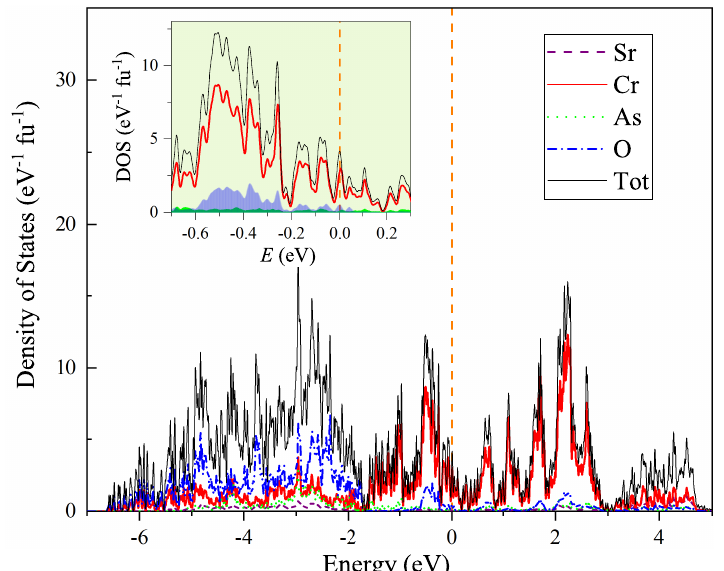
Figure 8. Energy dependence of total and partial electronic density of states (DOS) of the C-type antiferromagnetic state of Sr 2 Cr 2 AsO 3